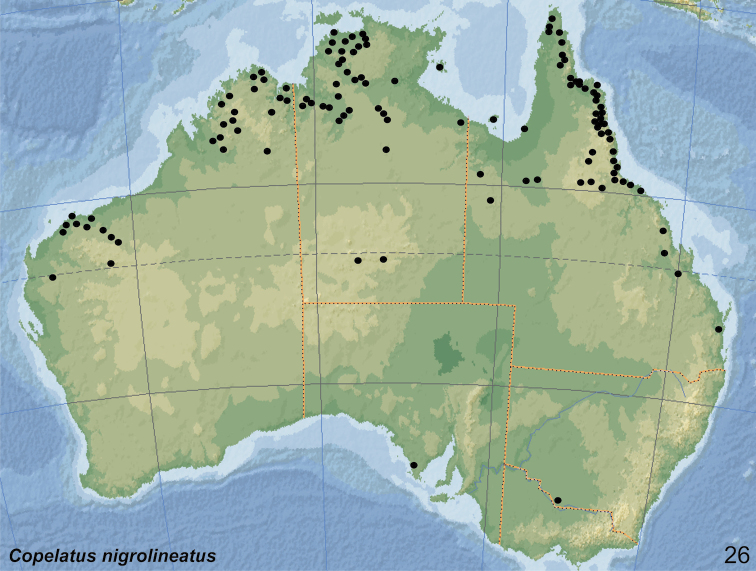
Distribution of Copelatus
nigrolineatus.